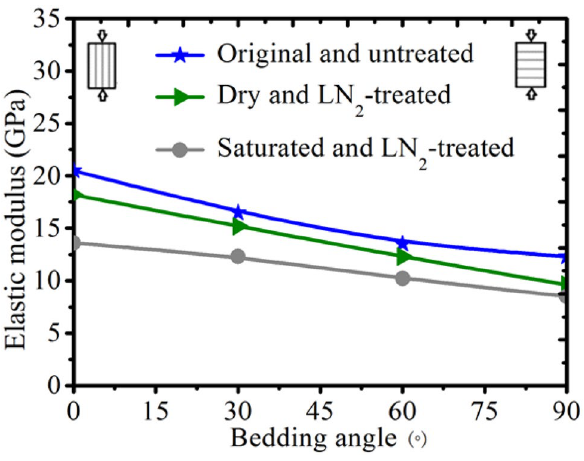
Fig. 7 Elastic modulus values of different bedding shales before and after LN 2 cooling